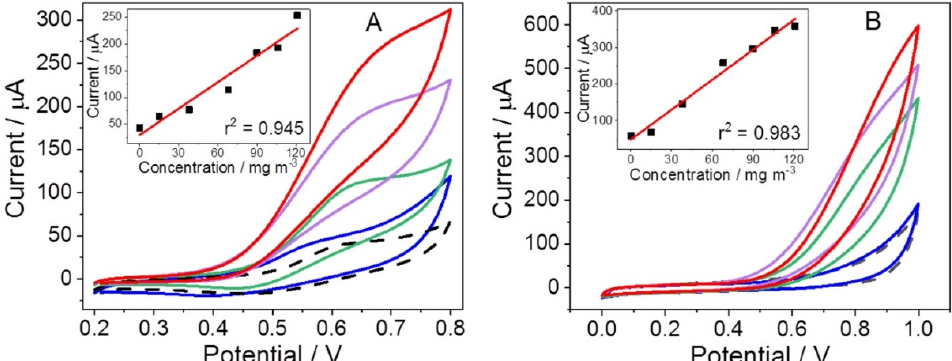
Figure 14. Cyclic voltammograms obtained at the MnO 2 /PAA ( A ) and PAA ( B ) sensors for successive increments of gaseous H 2 O 2 concentrations in the range of 15–121 mg m − 3 (voltammograms for 15, 68, 106 and 121 mg m − 3 are shown) together with a background response (dashed line). The insets show the corresponding calibration plots. Reprinted with permission from Ref. [125]. Copyright 2021 Elsevier.